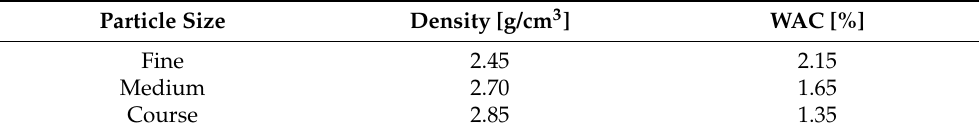
Table 5. Physical properties of the natural aggregates.